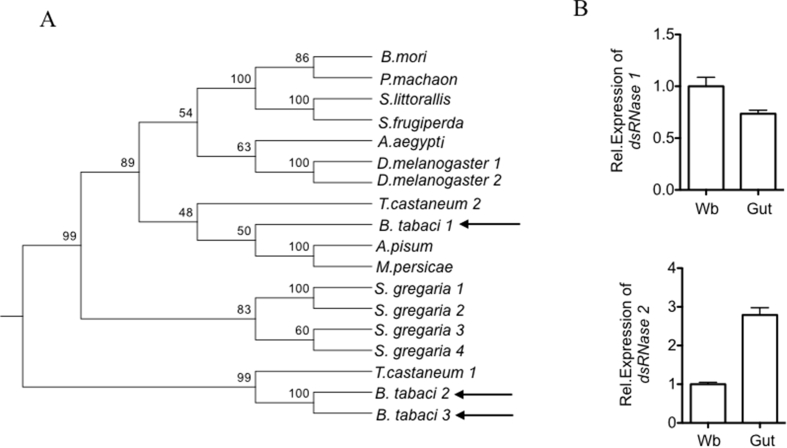
The dsRNase genes of Bemisia tabaci. (A) Neighbor-joining phylogenetic tree constructed using the protein sequence of the conserved DNA/RNA non-specific nuclease domain of insect dsRNase genes. The numbers at the branches indicate the %bootstrap support, based on the frequency of the clusters for 1000 bootstraps. The dsRNase sequences were: Bombyx mori 2 (NP_001091744.1), Papilio machaon (XP_014355571.1), Spodoptera littorallis (CAR92522.1), Spodoptera frugiperda (CAR92521.1), Aedes aegypti (XP_001648469.1), Drosophila melanogaster 1 (NM_140821.4), D. melanogaster 2 (NP_649078.1, CG3819), Tribolium castaneum 1 (XP_973587.1), T. castaneum 2 (XP_970494.1), Schistocerca gregaria 1 (KJ135008), S. gregaria 2 (KJ135009), S. gregaria 3 (KJ135010), S. gregaria 4 (KJ135011), Acyrthosiphon pisum (ACYPI008471), Myzus persicae (MYZPE13164_0_v1.0_000125730.4_pep) and Bemisia tabaci 1(KX390872), B. tabaci 2 (KX390873) and B. tabaci 3 (Unigene11878_BT_Q_SG_ZJU). (B) qRT-PCR analysis of the expression of BtdsRNase-1 (top) and BtdsRNase-2 (bottom) in dissected guts of B. tabaci, relative to the whole body (Wb). Mean ± s. e. from 3 replicates are shown.